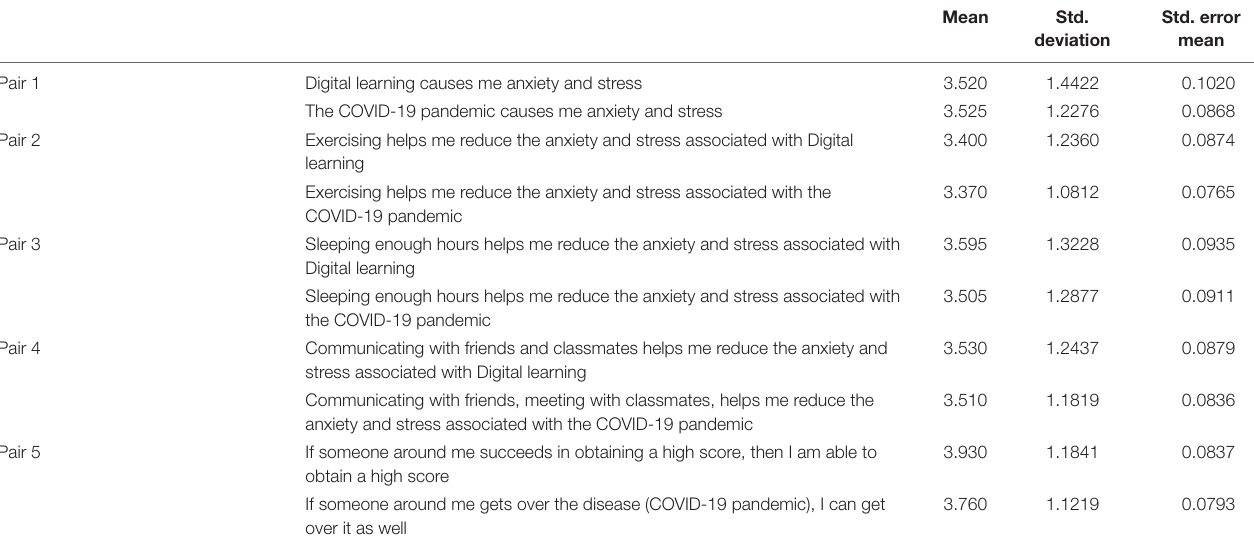
TABLE 4 | Descriptive statistics (Section 2: Digital learning in time of COVID-19, stress, psychological effects and its role in defense mechanisms and coping strategies).